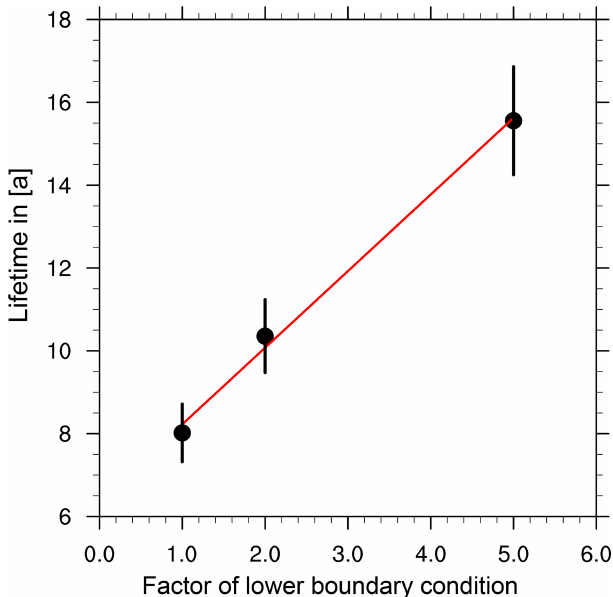
Figure 2. CH 4 lifetime calculated according to Eq. (1) vs. the cor- responding scaling factor applied to the reference lower-boundary condition in the respective simulations: REF (1.0), S2 (2.0), S5